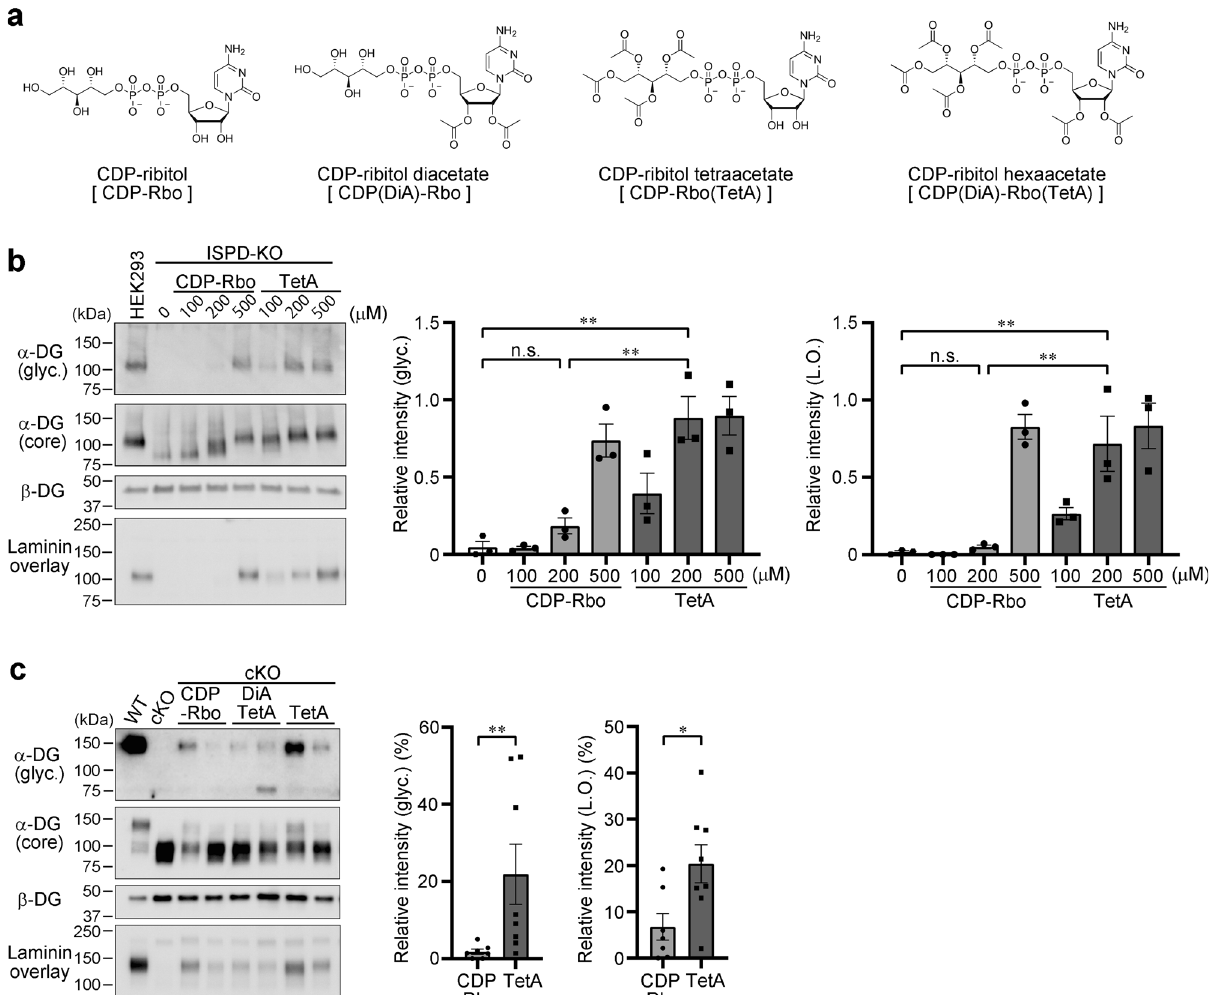
Fig. 4 Prodrug activity of CDP-Rbo derivatives. a CDP-Rbo derivative structure formulae. b In vitro prodrug activity of CDP-Rbo derivatives in ISPD- de fi cient HEK293 cells. α -DG glycosylation was measured using western blot analysis with antibodies against matriglycan (glyc., IIH6) and core protein (3D7) and laminin overlay assay. β -DG was used as a loading control. DG from wild-type HEK293 cells was used as a positive control. Right: relative matriglycan signal intensity (ratio of glyc./ β -DG) and laminin-binding activity (ratio of laminin binding/ β -DG) compared to those in WT HEK293 cells. Data were analyzed using ANOVA with Tukey ’ s post hoc test. ** p < 0.01 (200 μ M CDP-Rbo vs. 200 μ M TetA, p = 0.003 and 0.009; and 0 μ M CDP-Rbo vs. 200 μ M TetA, p = 0.001 and 0.007 for IIH6 and laminin overlay, respectively; n = 3). c In vivo prodrug activity of CDP-Rbo derivatives injected into skeletal muscles. CDP-Rbo or CDP-Rbo derivatives were injected twice every 3 days (days 1 and 4). Three days after the second injection (day 7), the injected muscles were harvested. α -DG glycosylation was measured using western blot analysis with antibodies against matriglycan (glyc., IIH6) and core protein (3D7) and laminin overlay assay. β -DG was used as a loading control. Right: relative matriglycan signal intensity (ratio of glyc./ β -DG) and laminin- binding activity (ratio of laminin binding/ β -DG) compared to those in WT muscle. Data were analyzed using the Mann-Whitney U test ( p = 0.006 and 0.04 for IIH6 and laminin overlay, respectively; CDP-Rbo, n = 7; TetA, n = 8). * p < 0.05, ** p < 0.01. TetA, CDP-Rbo(TetA). DiATetA, CDP(DiA)- Rbo(TetA). L.O., laminin